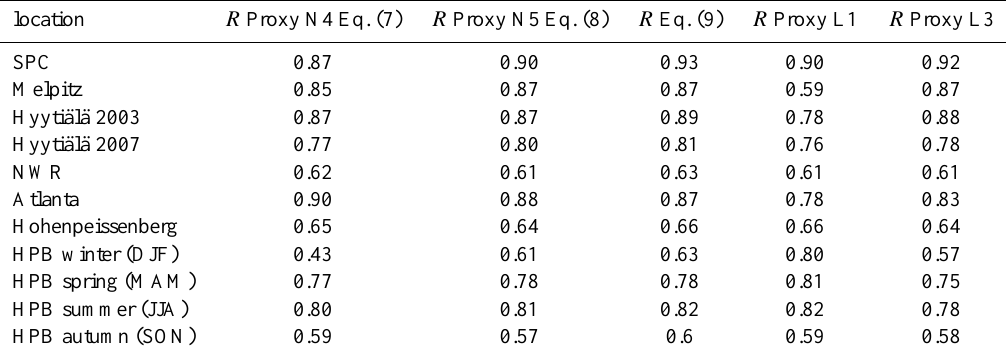
Table 7. Correlations of observed sulphuric acid concentrations in different datasets vs. values predicted with the proxy calculated from the combined campaign